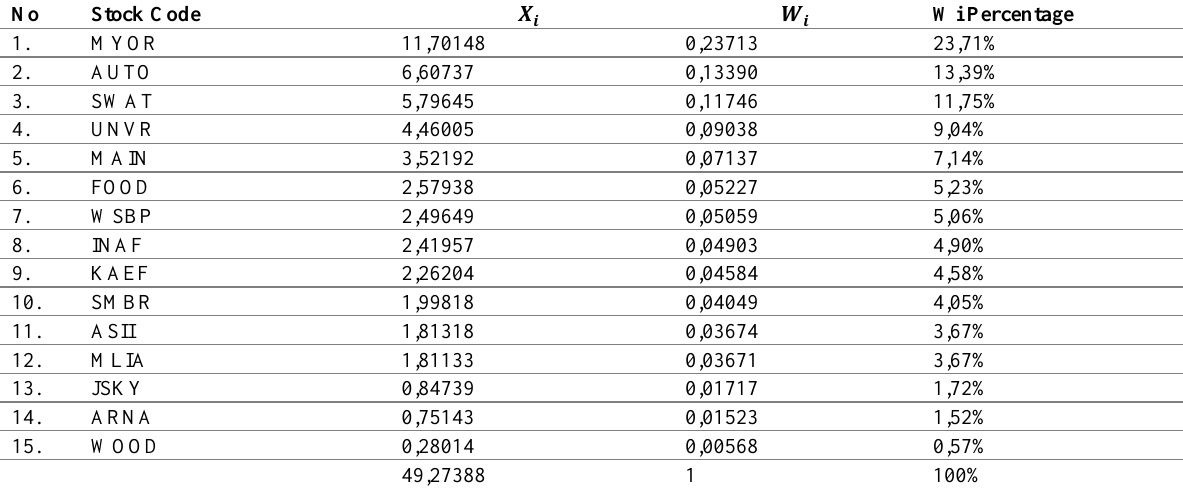
Table 5: Proportion of Funds of Each